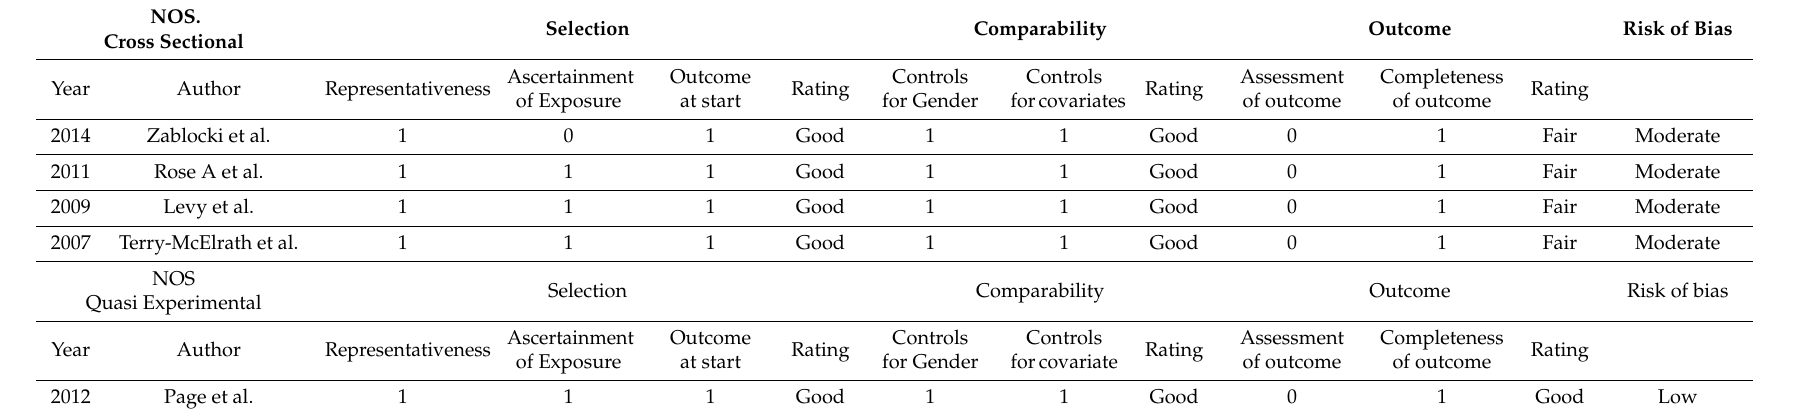
Table 2. Risk of bias assessment using modified Newcastle Ottawa Scales